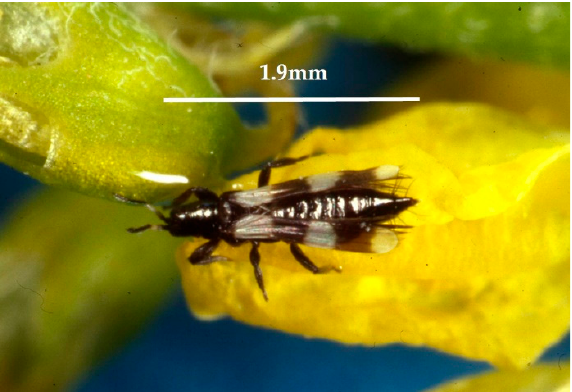
Figure 2. Female of the predatory thrips Aeolothrips intermedius (Photo by R. Antonelli). In Europe, A. intermedius larvae are reported as predators of Heliothrips haemorrhoidalis Bouché, Odontothrips confusus Priesner, and some species belonging to the genus Haplothrips [20]. A. intermedius is considered the primary native predator of Thrips tabaci [20–24] and a good candidate for the biological control of onion thrips in field conditions [25]. However, despite that A. intermedius has been reported as a very effective predator that may play an important role in the biological control of Thysanoptera [26], there is little information on its specific predation rate against T. tabaci . Thus, the aim of our study was to assess, using laboratory tests, the predatory efficiency of A. intermedius larvae against the crop insect pest T. tabaci. In particular, the predation tests carried out in this study were aimed to evaluate (a) the predation times of A. intermedius larvae on T. tabaci adults; (b) the predation rate of A. intermedius larvae on T. tabaci adults.